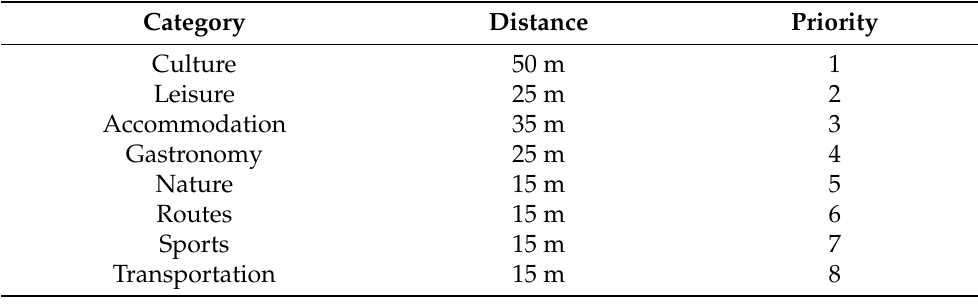
Algorithm 2 Activity identification